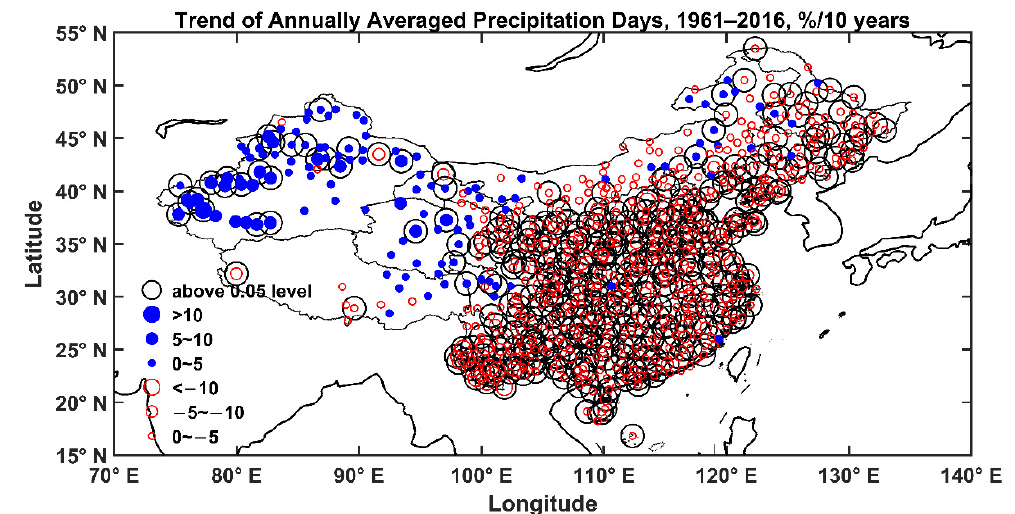
Figure 5. The decadal trend of the relative change of annual precipitation days at 635 stations.